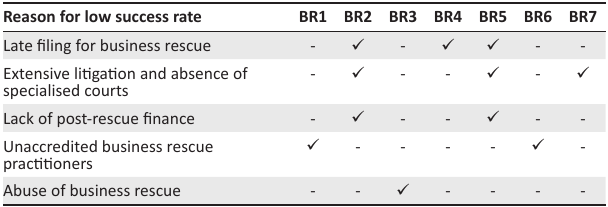
FIGURE 1: Reasons provided for the unpreparedness in the application of the legislation. TABLE 1: Reason for low success rate in a business